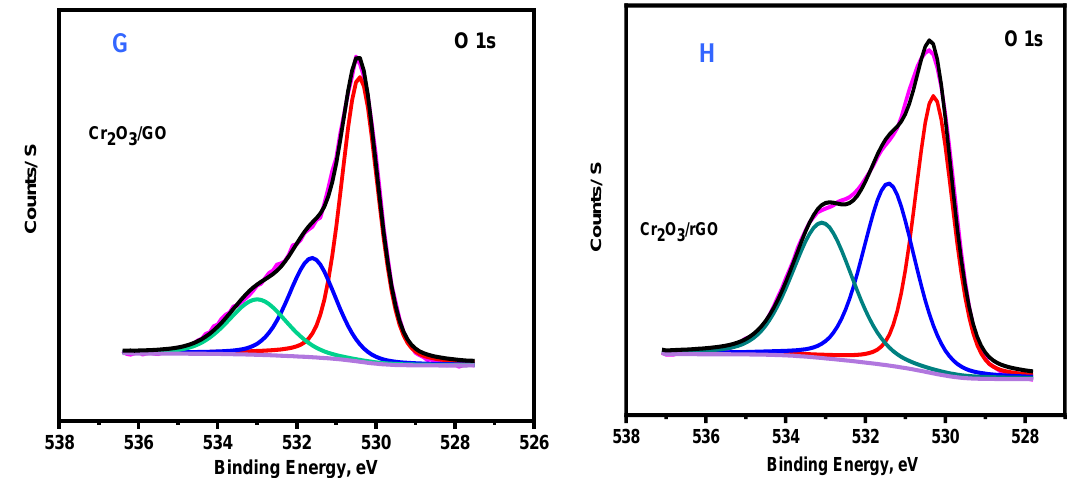
Figure 5. Deconvoluted XPS peaks of ( A ) Cr(2p) and ( B ) O(1s) for the crystalline Cr 2 O 3 ; ( C ) Cr(2p), ( E ) C(1s) and ( G ) O(1s) peaks for Cr 2 O 3 /GO; and ( D ) Cr(2p), ( F ) C(1s) and ( H ) O(1s) peaks for Cr 2 O 3 /rGO.